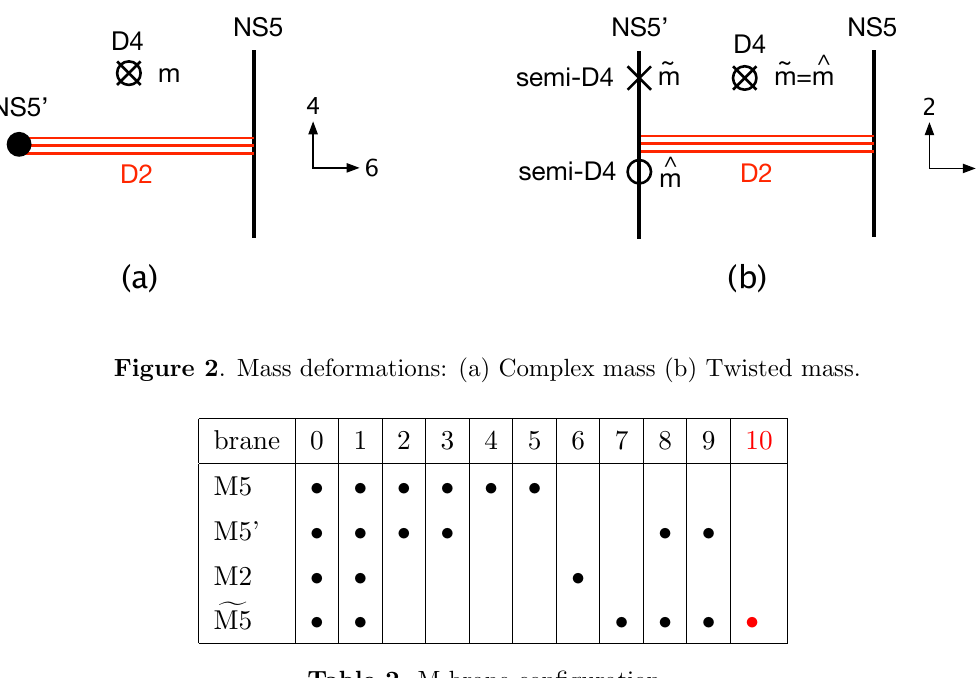
Figure 1 . (a) Type IIA brane con(cid:12)guration for U( k ) with n fundamentals. (b) n